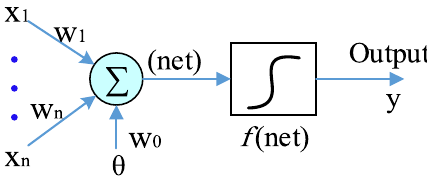
Figure 8. A simple mathematical model of neurons in